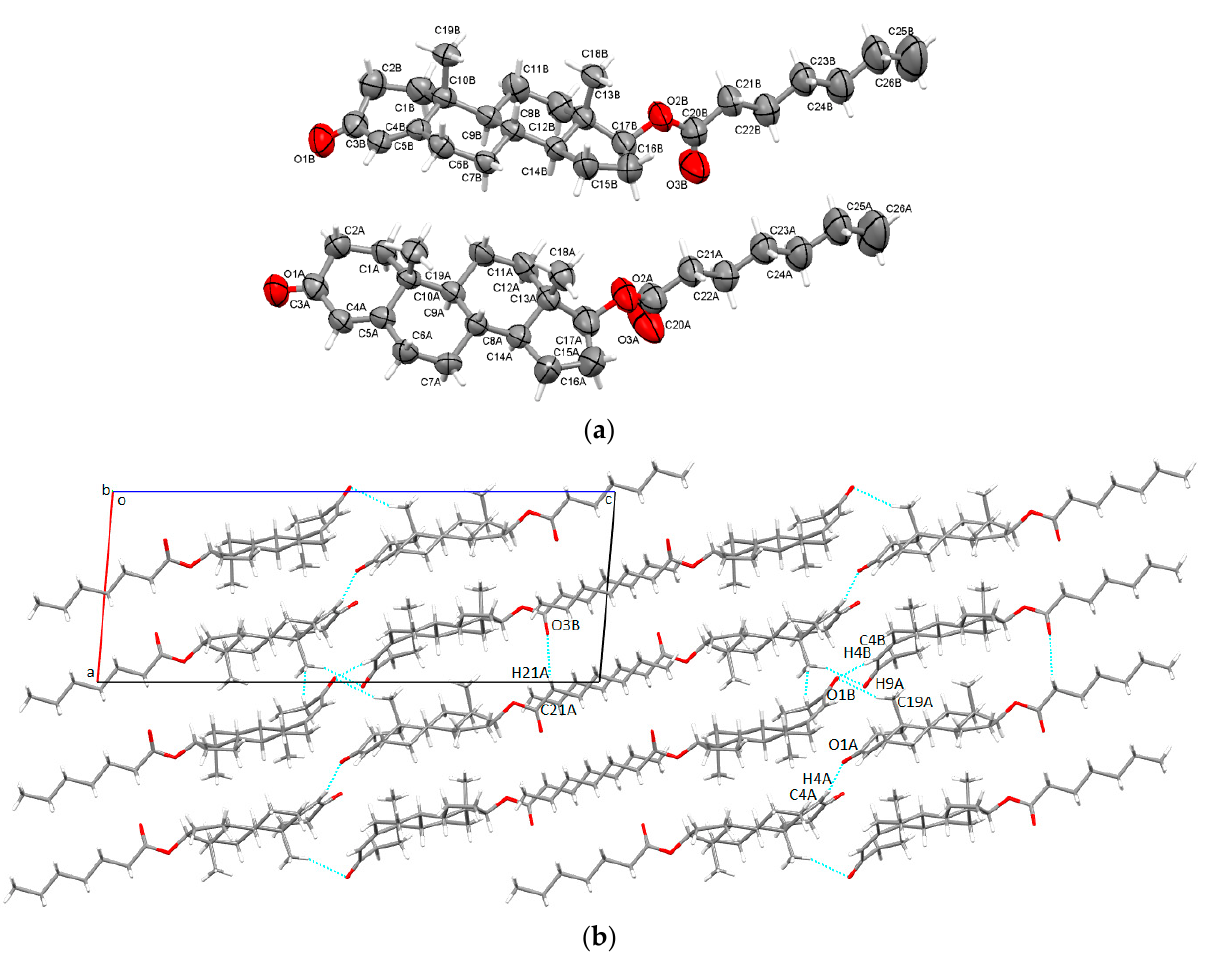
Figure 2. Asymmetric unit of Tena presenting non-hydrogen atoms at 50% probability level ( a ); overall packing viewed along b-axis ( b ) . packing viewed along b-axis ( b